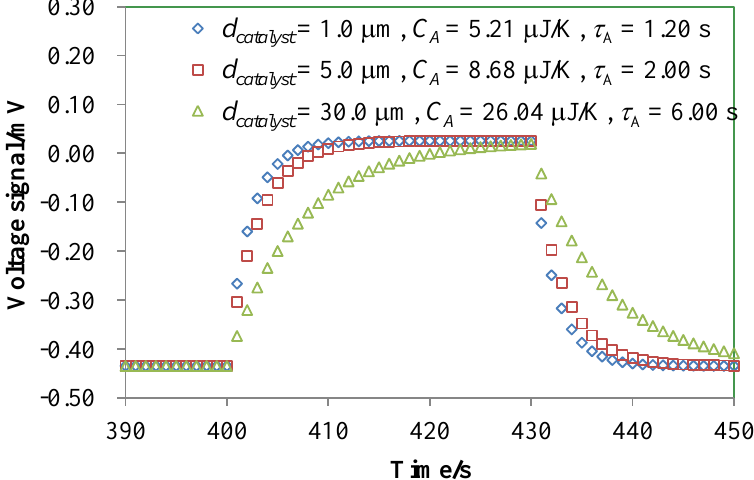
was 10.0  catalyst